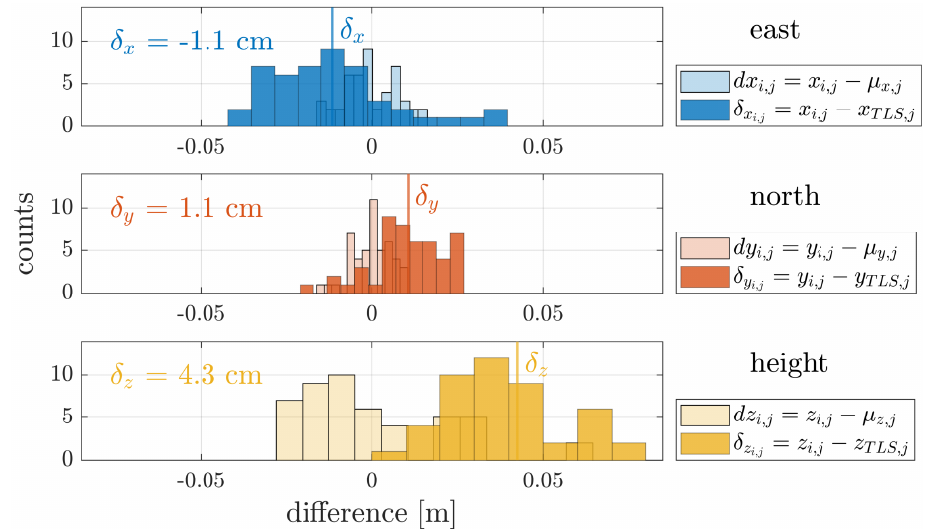
Figure 12. Difference of the estimated target coordinates compared to the TLS reference considering the east (blue), north (red) and height (yellow) coordinates. A total of 12 targets are estimated for each of the four repeat